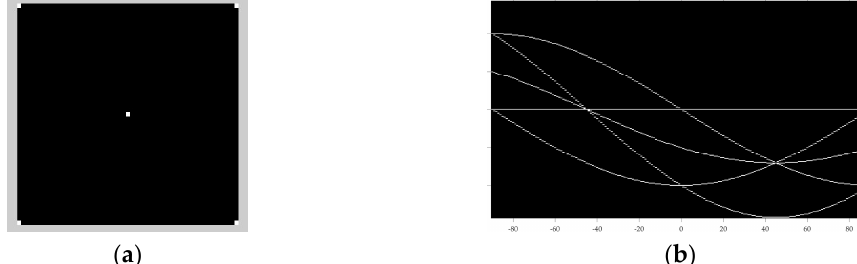
Figure 3. Example of line detection based on Hough transform (HT). ( a ) Image space with five points